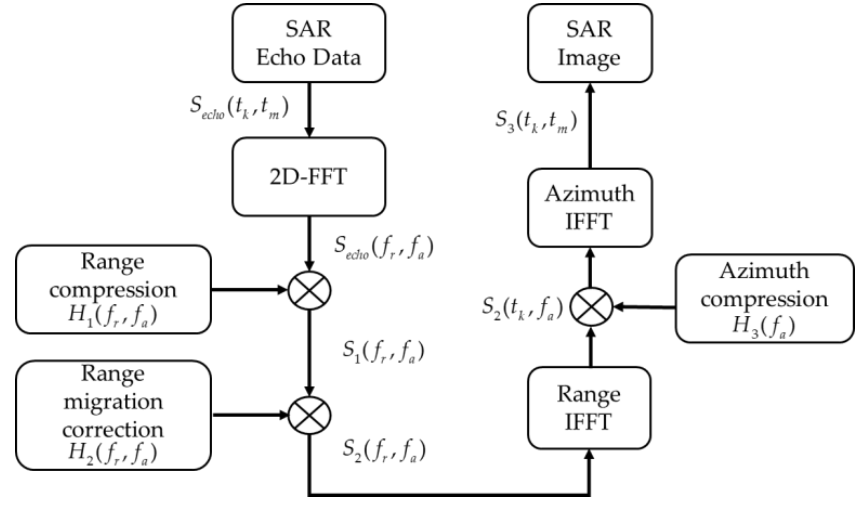
Figure 2. Flow chart of SAR-GMT imaging algorithm.